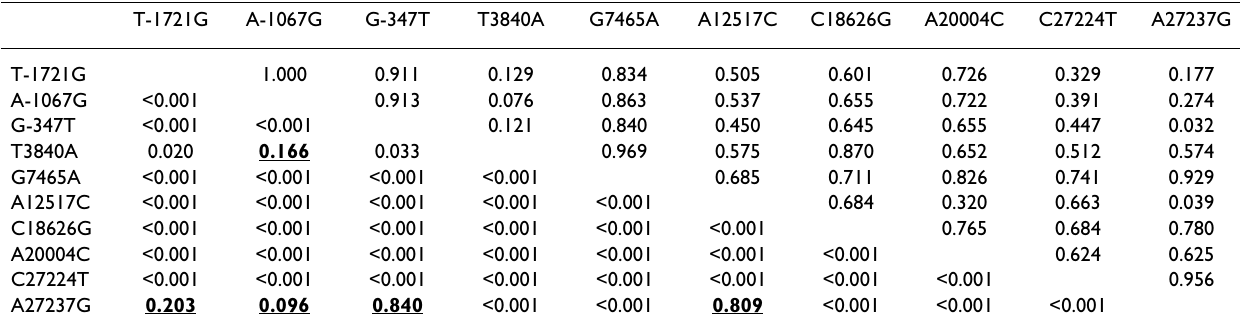
Table 3: Pairwise linkage disequilibrium indicated by the D' value (above the diagonal) a and statistical significance indicated by the p value (below the diagonal) b for the ten TPH1 SNPs.